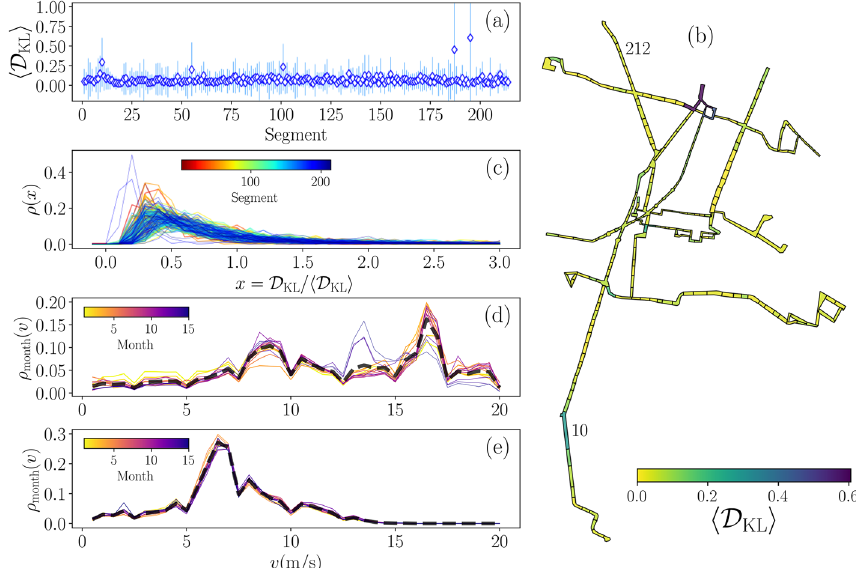
Figure 3. Statistical analysis of the distances D KL for speed densities. ( a ) Average Kullback–Leibler distances (cid:31) D KL (cid:30) in each segment, error bars represent the standard deviation of the values. ( b ) Average values (cid:31) D KL (cid:30) represented in the segments map. ( c ) Probability densities of the values D KL / (cid:31) D KL (cid:30) in each segment codified in the color bar. Probability densities ρ month ( v ) of the speed v at the scale of months for: ( d ) segment 10 with � D KL � = 0.296 and ( e ) segment 212 with � D KL � = 0.050 , dashed lines represent ρ total ( v ) for the segment. All figures were created using python 3.8 and the matplotlib (3.4.3) package (https:// matpl otlib. org). The map in panel ( b ) was created using the geopandas (0.10.2) package (https:// geopa ndas.